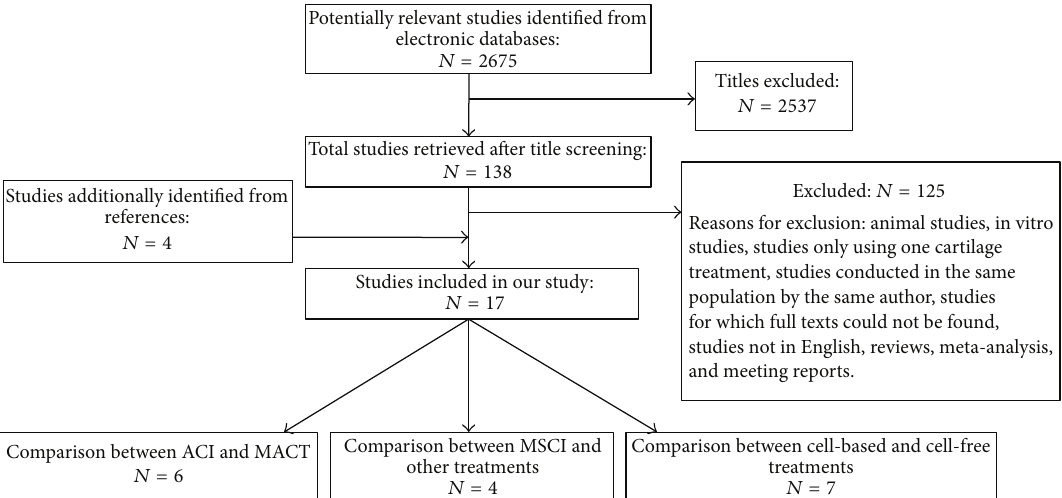
Figure 1: Scheme of research